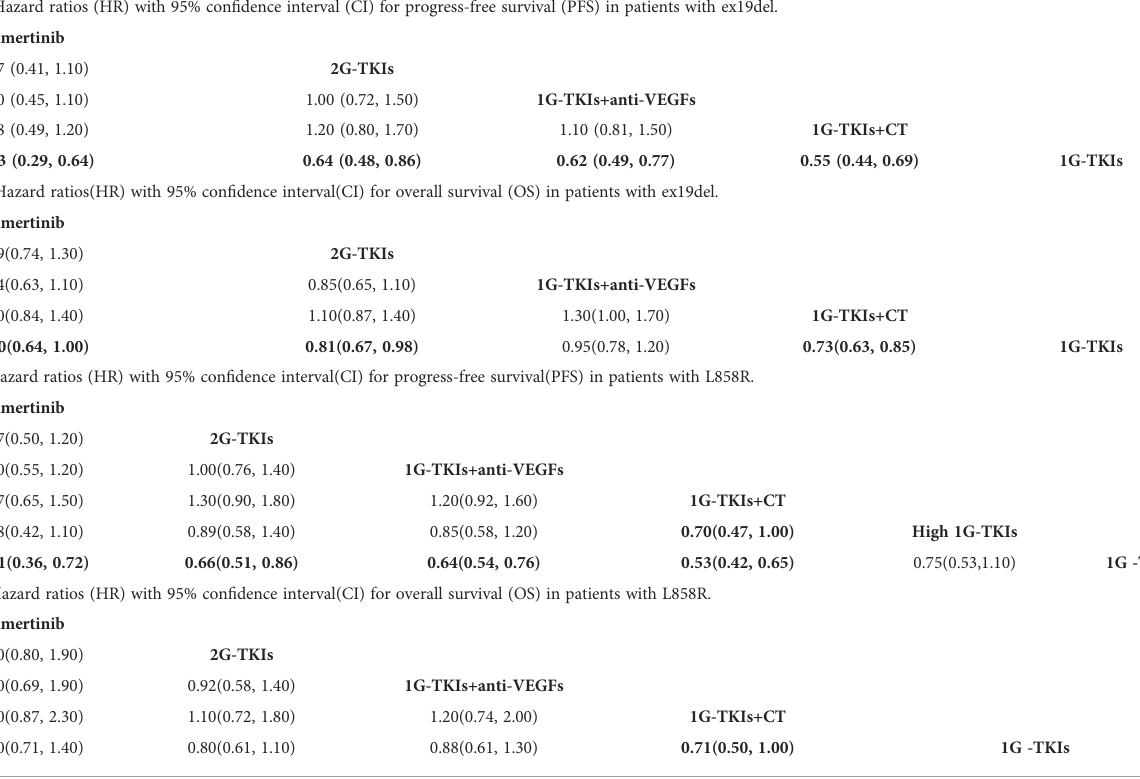
TABLE 2 Results of network meta-analysis for PFS and OS. a. Hazard ratios (HR) with 95% con fi dence interval (CI) for progress-free survival (PFS) in patients with